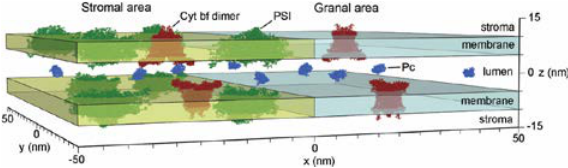
Fig. 7. Visualization of a part of the simulation area (100 × 100 nm) divided into stromal region with embedded PSI and Cyt b 6 f complexes (left), and granal region with Cyt b 6 f , but without PSI (right)